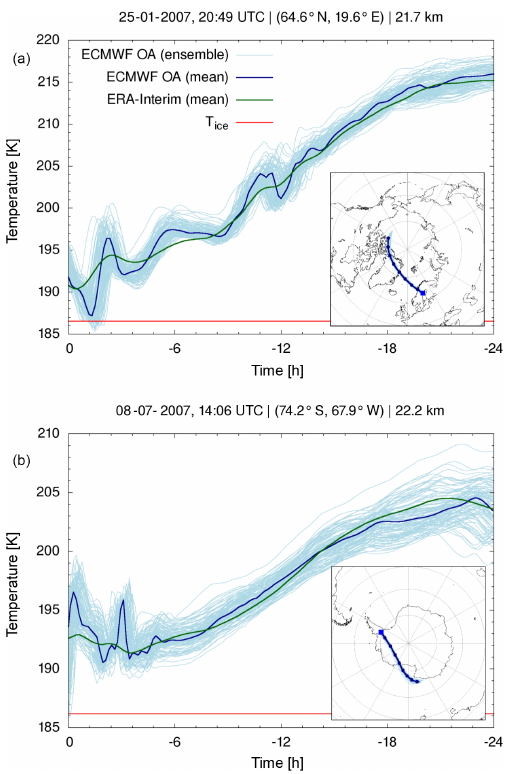
Figure 13. Temperature time series from the backward trajectory calculations for two of the case studies presented in Fig. 11. See plot titles for the time and location of MIPAS detections of ice PSCs that are used to define the trajectory seeds. Note that the time is dis- played on a reversed x axis with the MIPAS detection located at 0h. The calculations are based on ERA-Interim (green) and ECMWF operational analysis (OA; blue) meteorological data. The inset maps show the trajectory